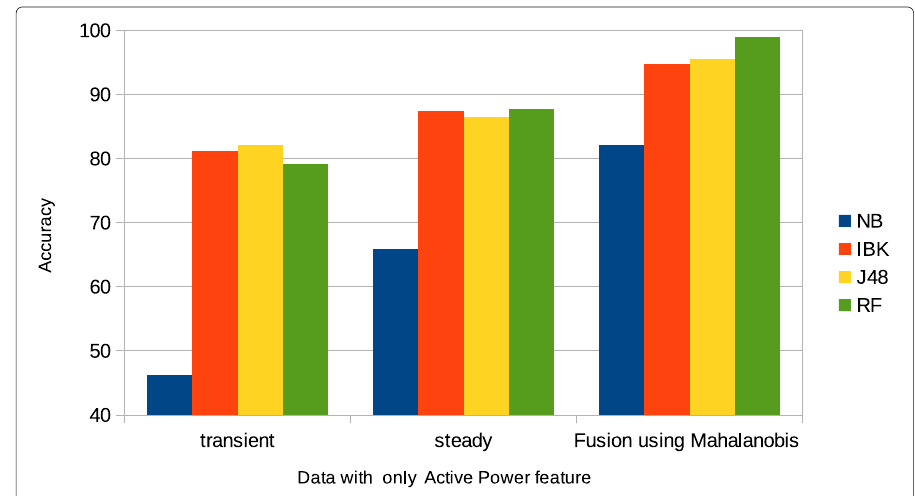
Fig. 6 Comparing Performance of fusion based NILM approach using only Active Power feature data